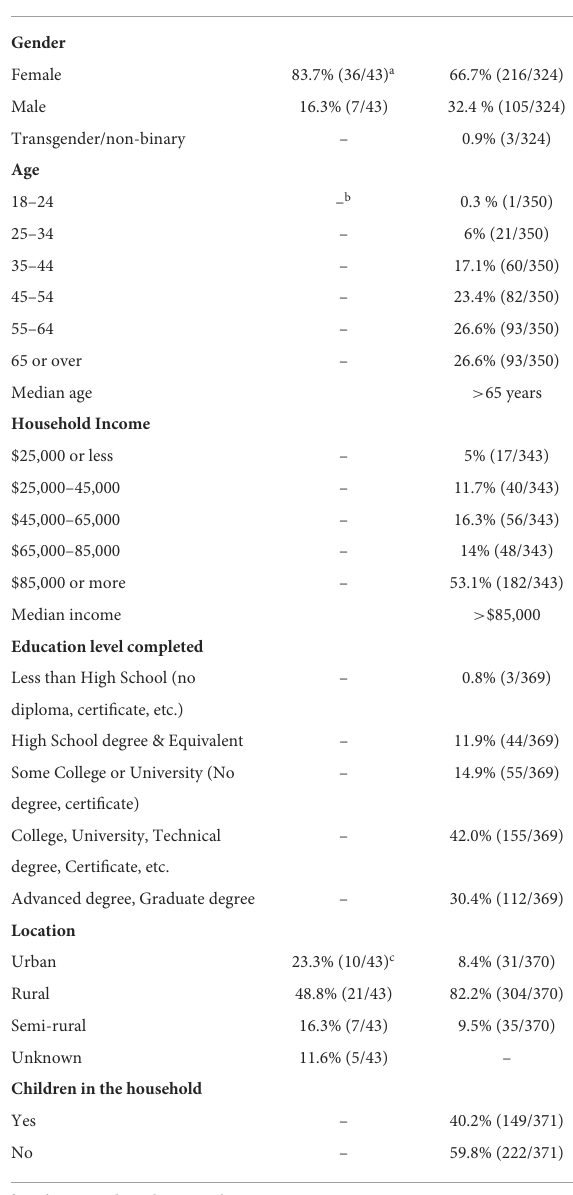
TABLE 4 Demographic characteristics of backyard chicken